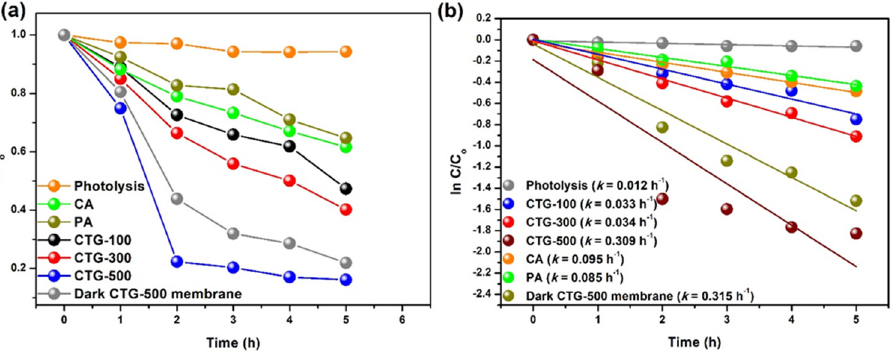
Figure 8. ( a ) Simultaneous filtration and photodegradation of KP (10 ppm, pH 5 for 5 h) using CTG—100, CTG—300, and CTG—500 membranes and ( b ) their reaction kinetics. Table 3. The removal efficiency of the different membranes and electrical energy consumption associated with the